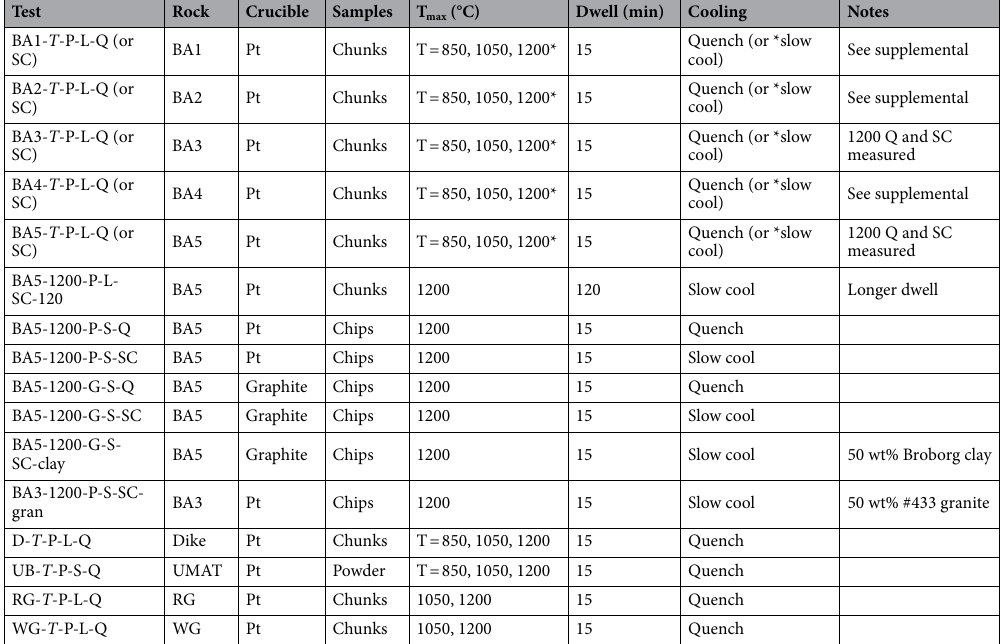
Test Rock Crucible Samples T max (°C) Dwell (min)